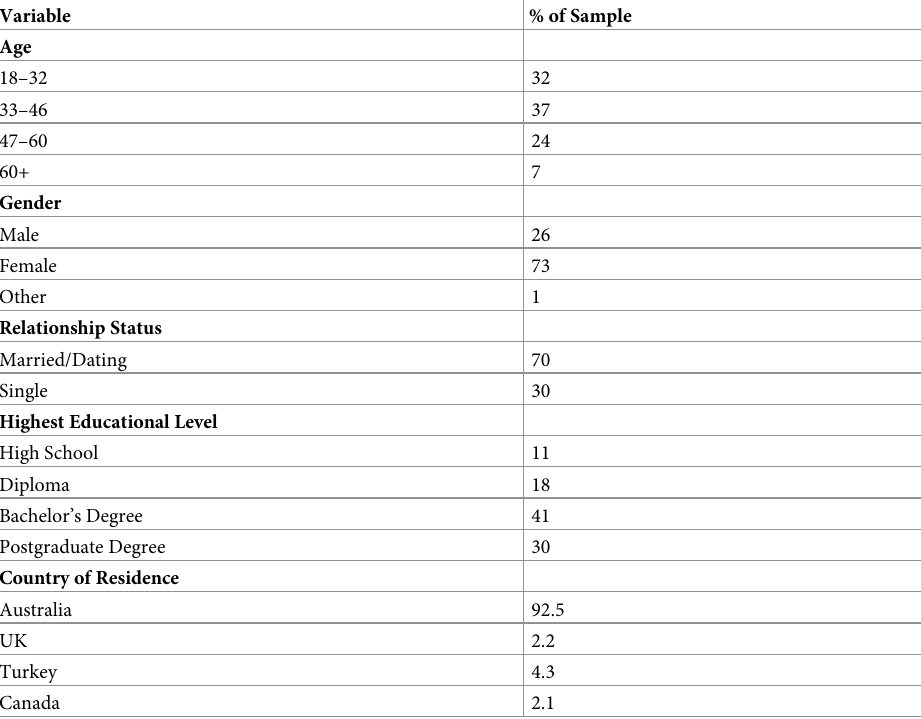
Table 1. Demographic characteristics of